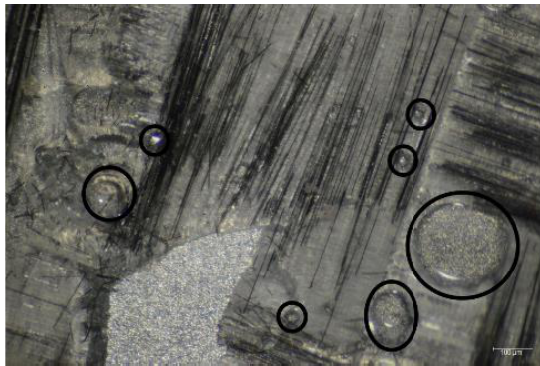
Figure 7. Carbon/epoxy delamination with air bubbles.